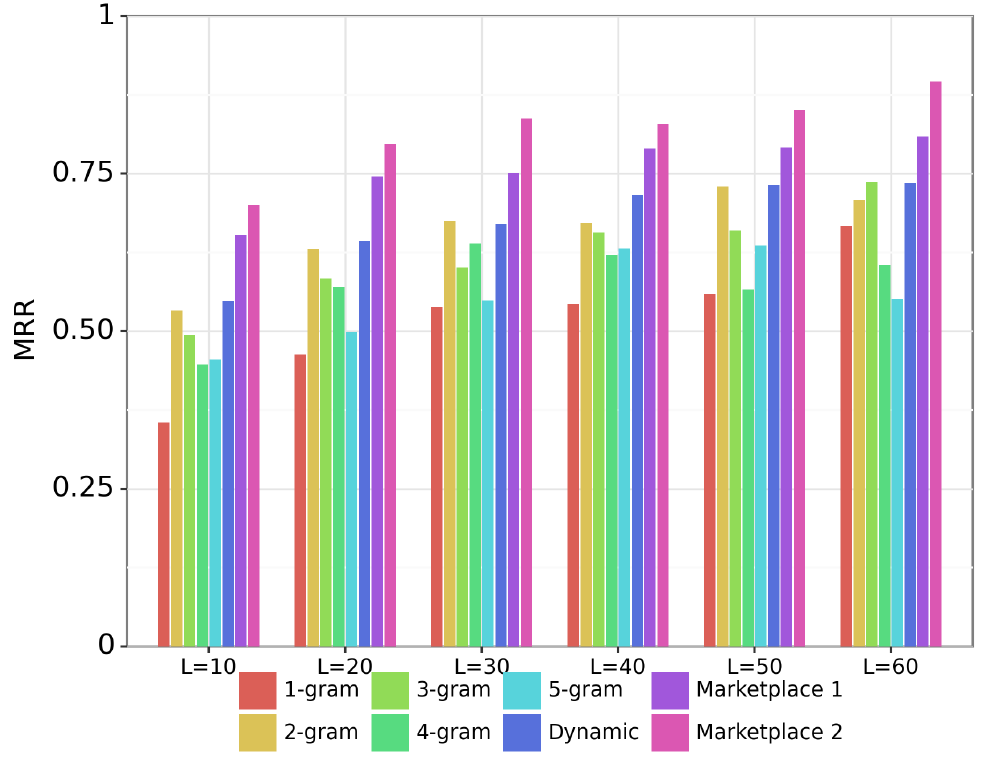
Figure 5. Experimental results on the audio-based sheet music retrieval task. Each query is an audio fragment of duration L seconds. The two marketplace systems are the same as in Figure